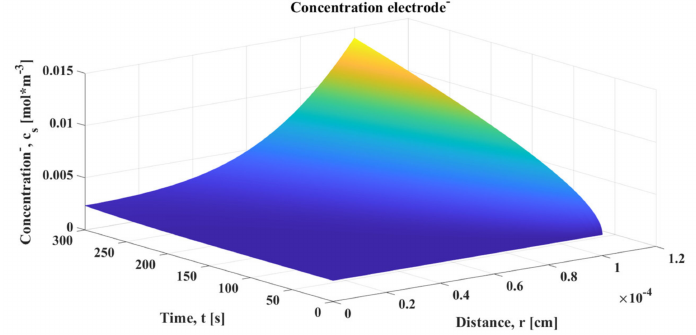
Figure 6. Concentration (Li + ) in the negative electrode of the cell (SPM).